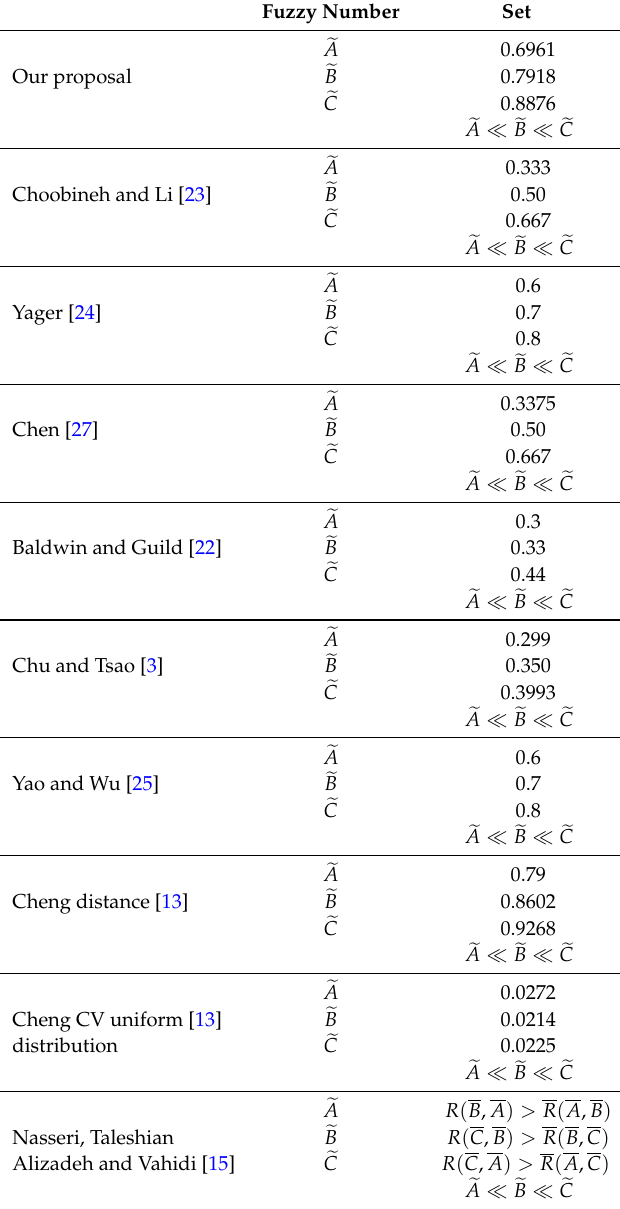
Table 2. Comparison of methods for ordering fuzzy